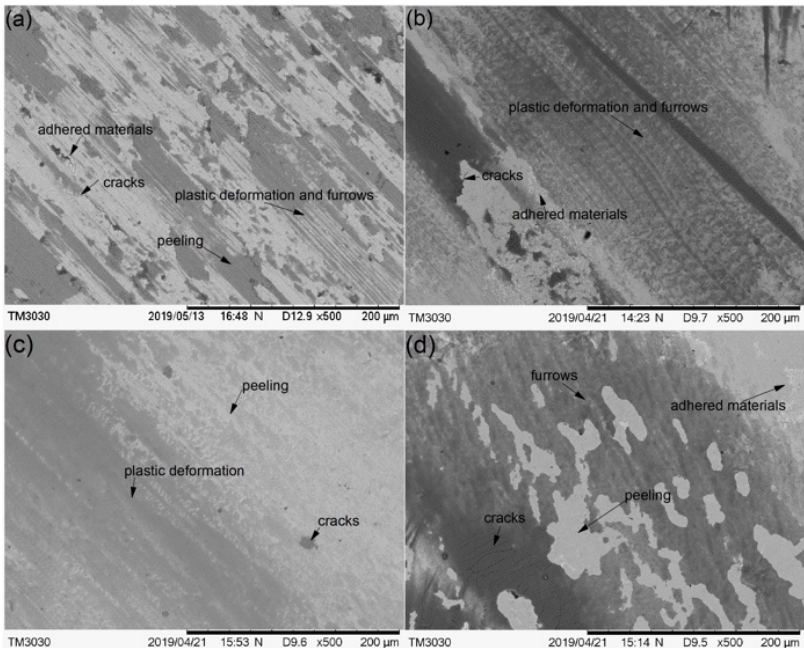
Figure 17. The SEM morphology of the worn substrate and cermet coatings: ( a ) substrate; ( b ) laser power of 2200 W; ( c ) laser power of 2500 W; ( d ) laser power of 2800 W.